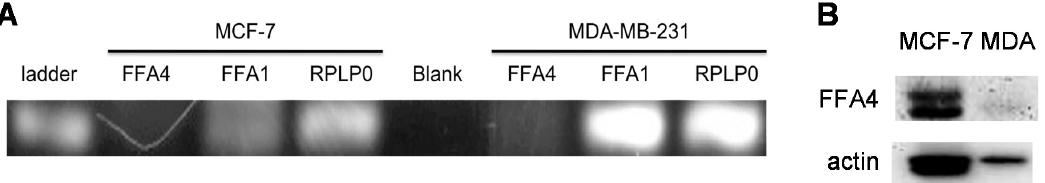
Figure 5. Expression of FFA1 and FFA4 in breast cancer cell lines. ( A ) RT-PCR reactions were carried out for human FFA4, FFA1, or RPLP0 (loading control) as described in Methods. Products were separated and visualized under UV light. Results shown are representative of two separate experiments, each done in triplicate. Faint signals for FFA4 were confirmed in additional experiments; ( B ) Whole-cell extracts, from MCF-7 and MDA-MB-231 cells growing in serum, were separated by SDS-PAGE and then immunoblotted for FFA4 and actin (loading control).